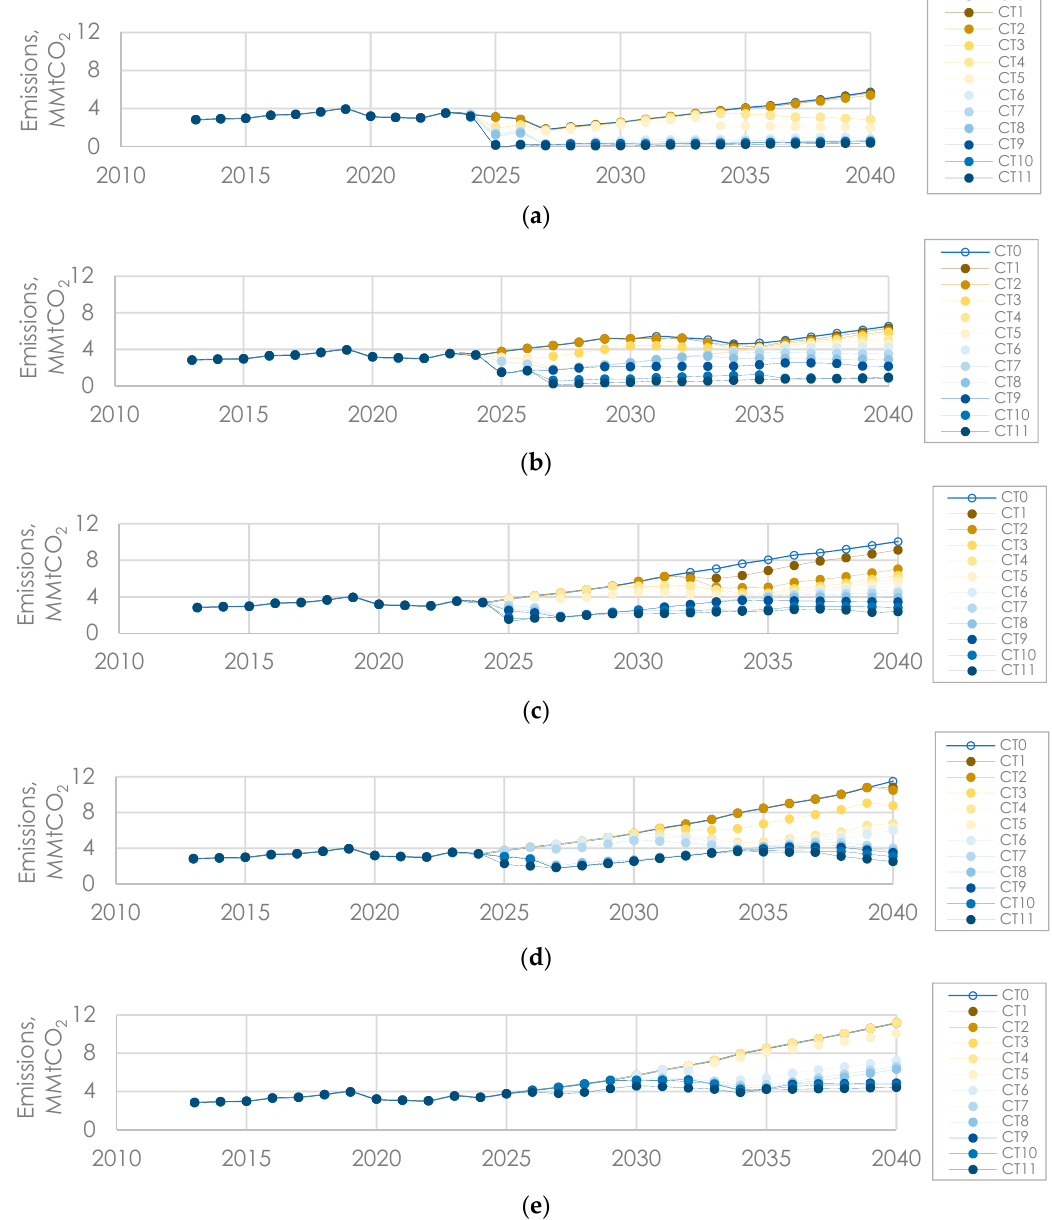
Figure 11. Annual Emissions for all discount rate and carbon tax scenarios. ( a ) WACC = 5%; ( b ) WACC = 8%; ( c ) WACC = 10%; ( d ) WACC = 12%; ( e ) WACC = 15%.